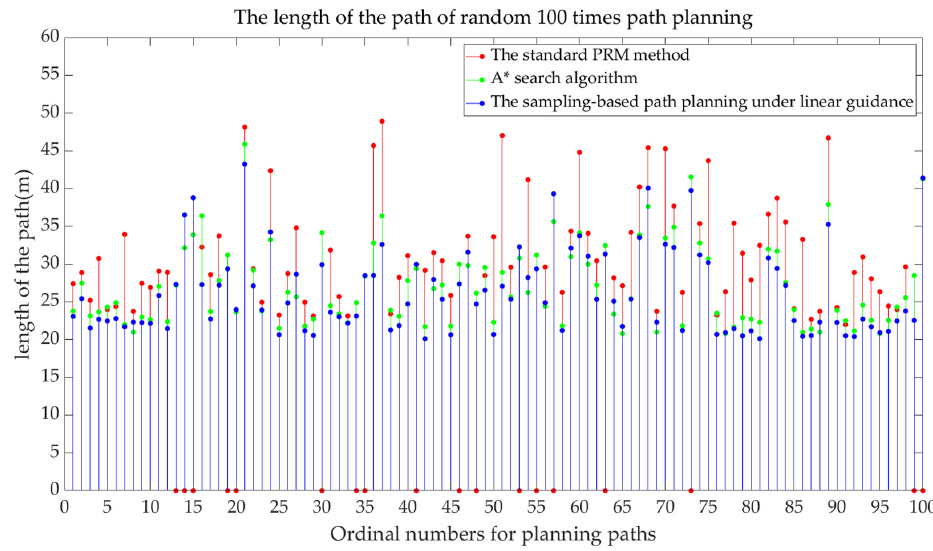
Figure 25. Comparison of the length of the path.